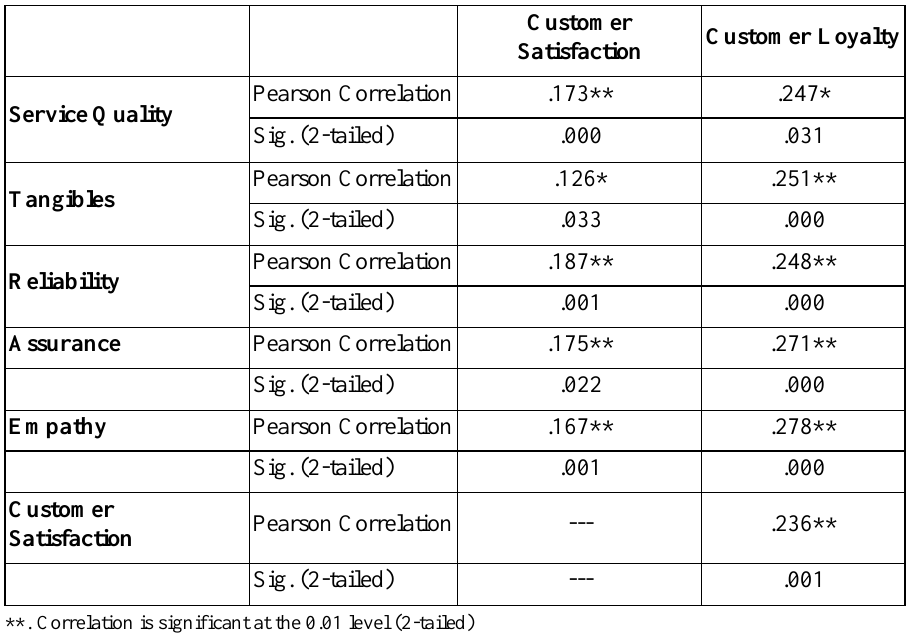
Table 4 : Pearson Correlation between Service Quality and Customer